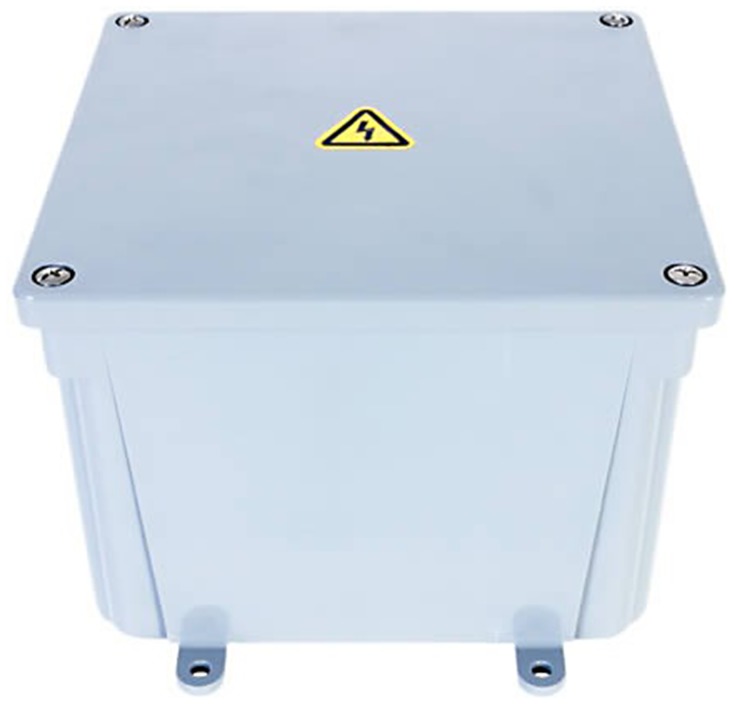
Electrical box camera case; camera lens is concealed by yellow electrical sticker in center (image courtesy of Supercircuits, Inc.).